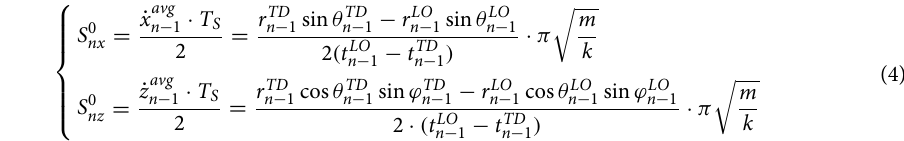
length, forward-swing angle, side-swing angle and time at TOUCHDOWN and LIFTOFF phase of the previous